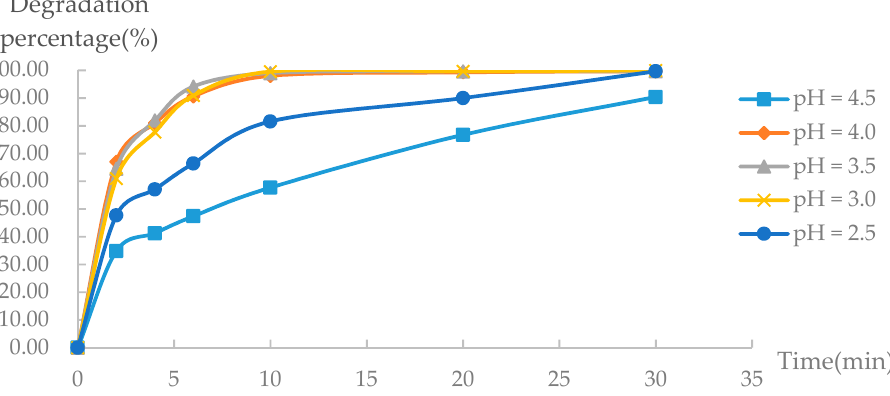
Figure 3. The influence of pH (2.5–4.5) on the degradation of